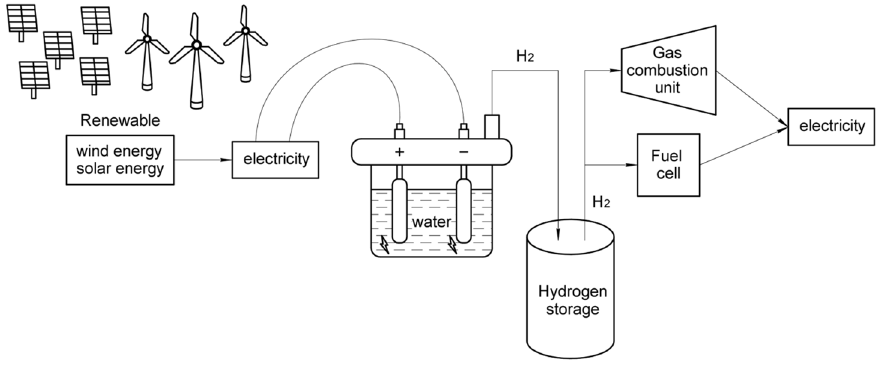
Figure 7. Hydrogen energy accumulation scheme.